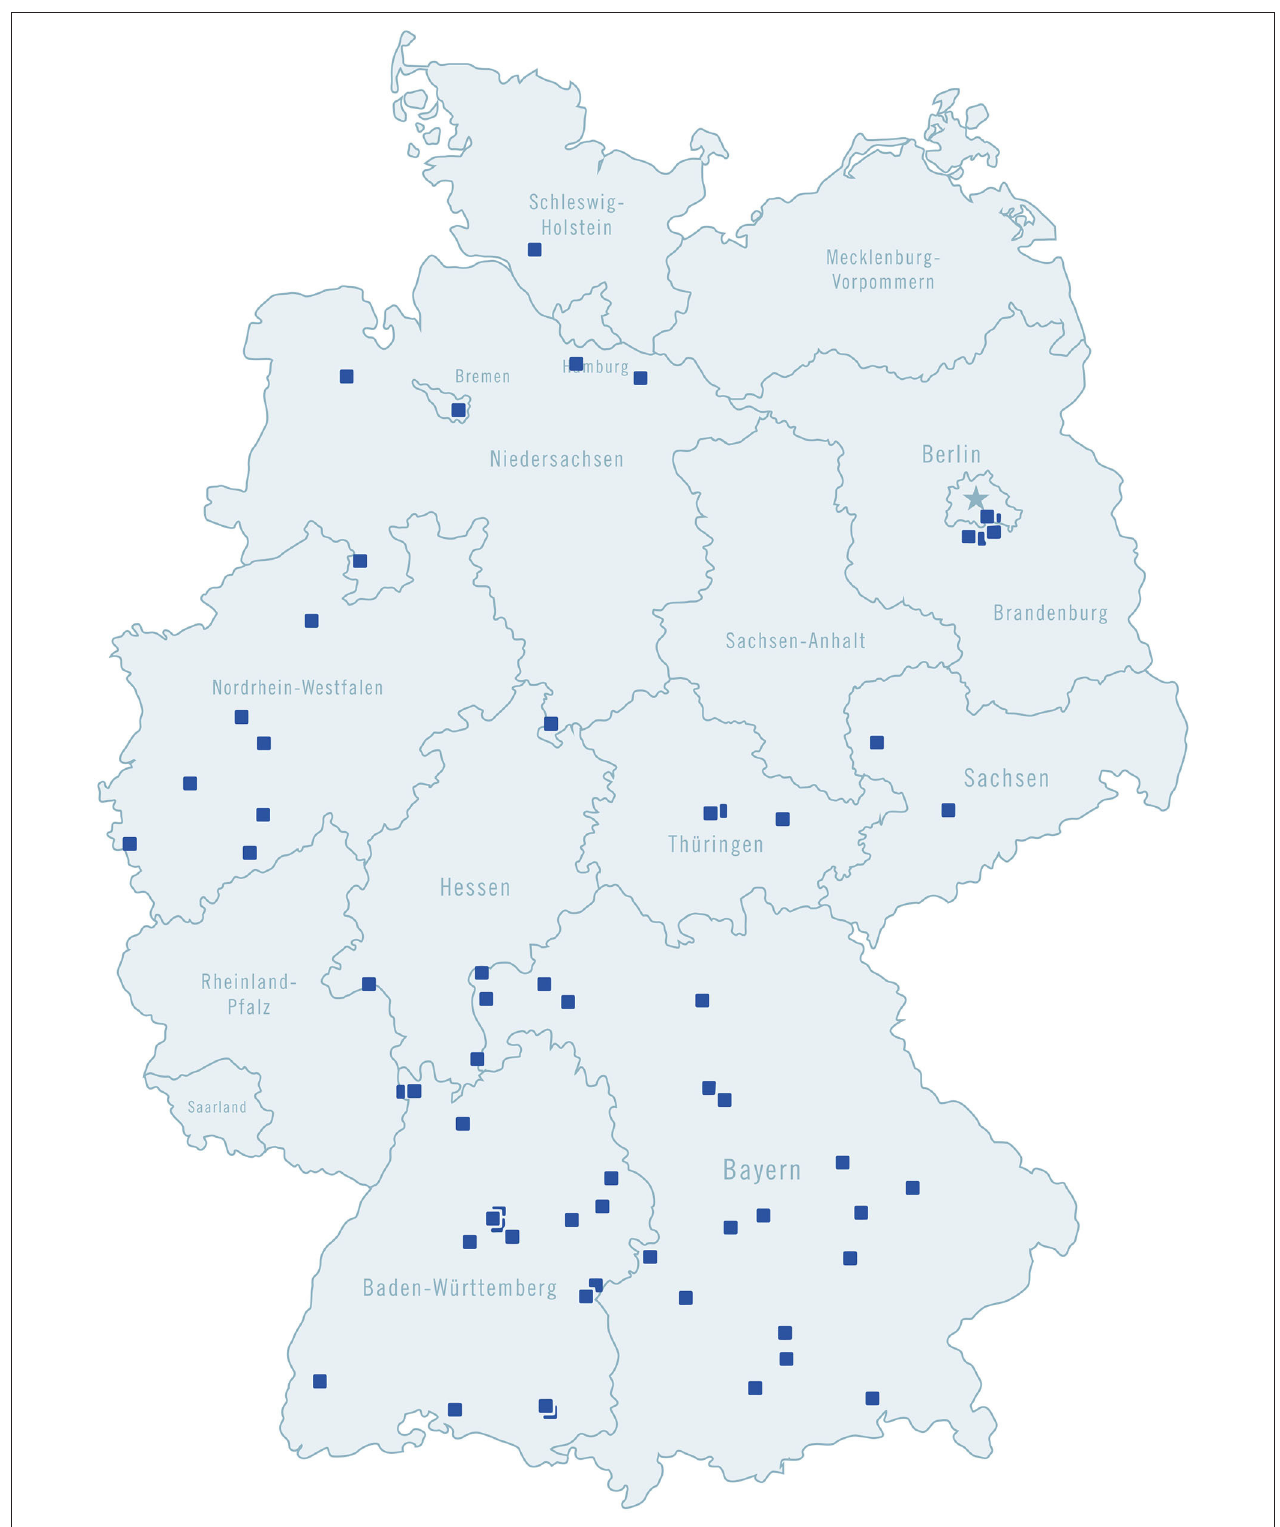
FIGURE 1 | NeuroTransData member practices in Germany.